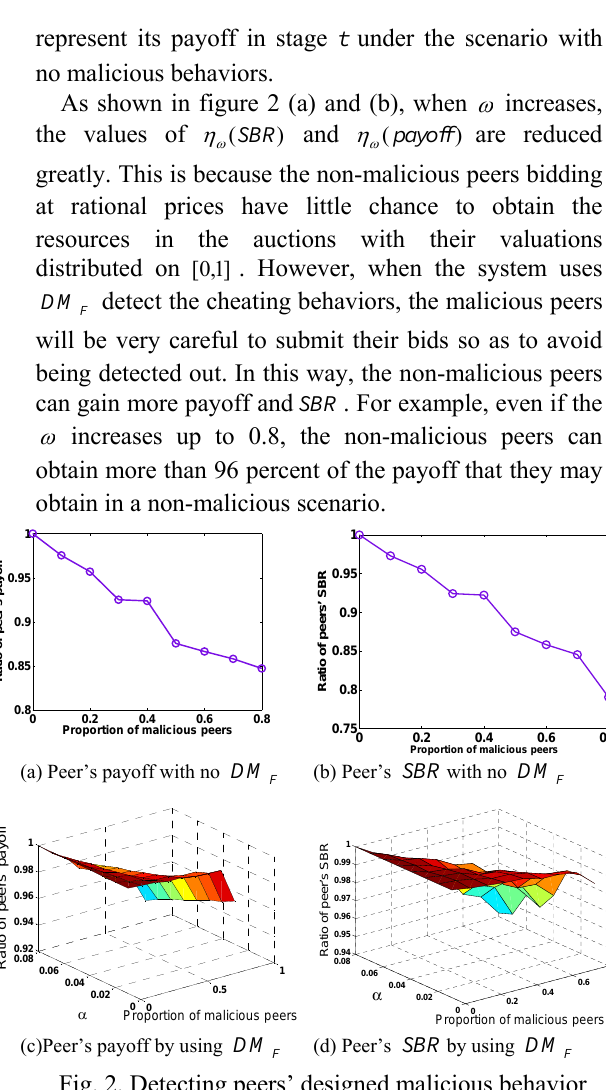
Fig. 2. Detecting peers’ designed malicious